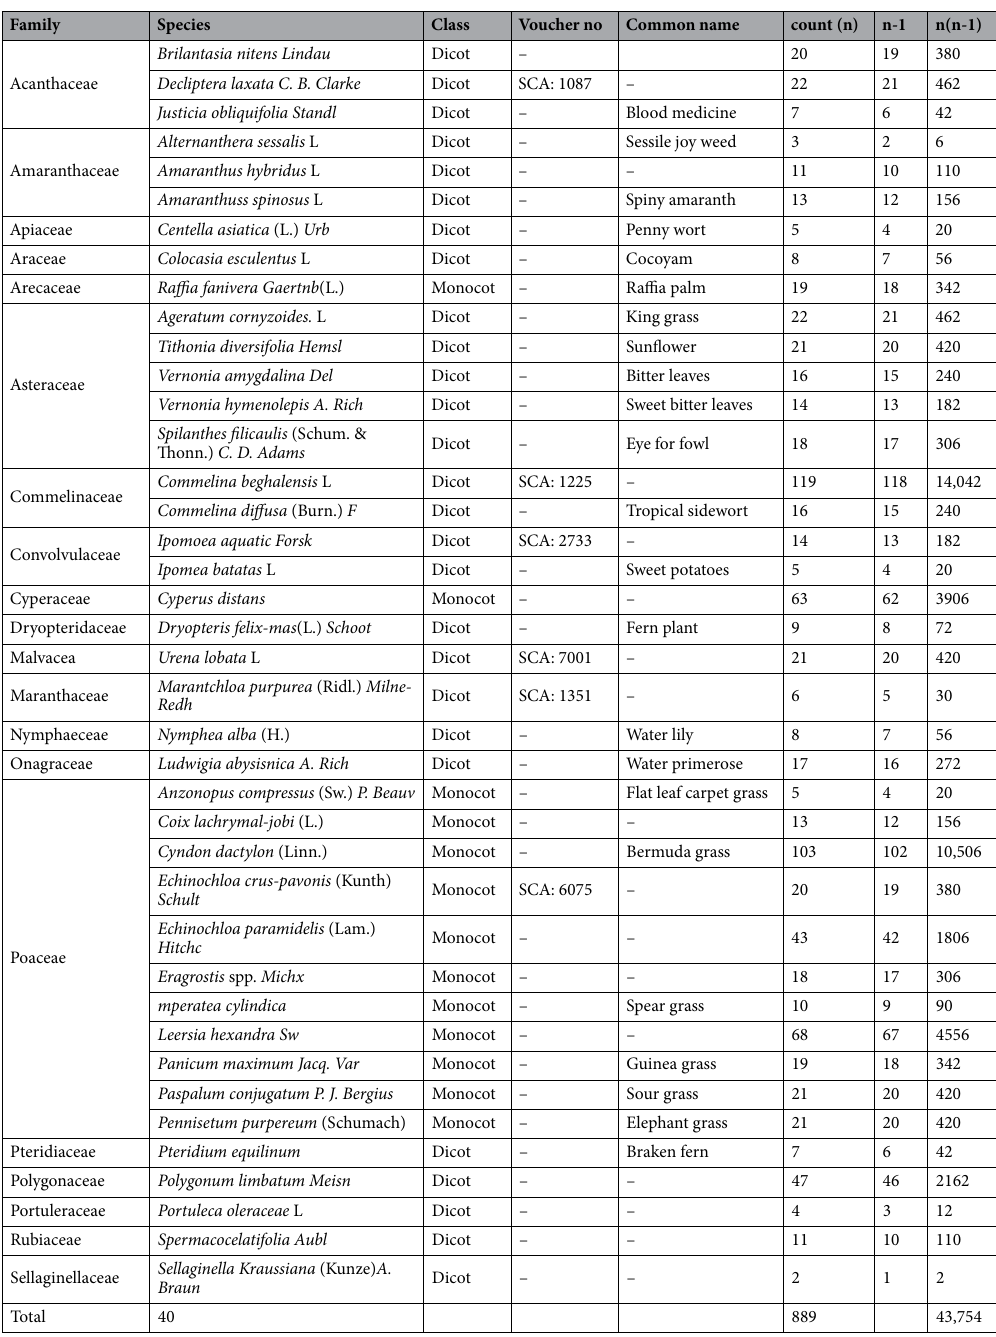
Table 4. Simpson index of diversity from vegetation samples at the Peri-urban site (Mile Four) in the Bamenda Municipality. SCA = Southern Cameroon (code for the Limbe Botanic Gaderns), D = 0.055425, Simpson =